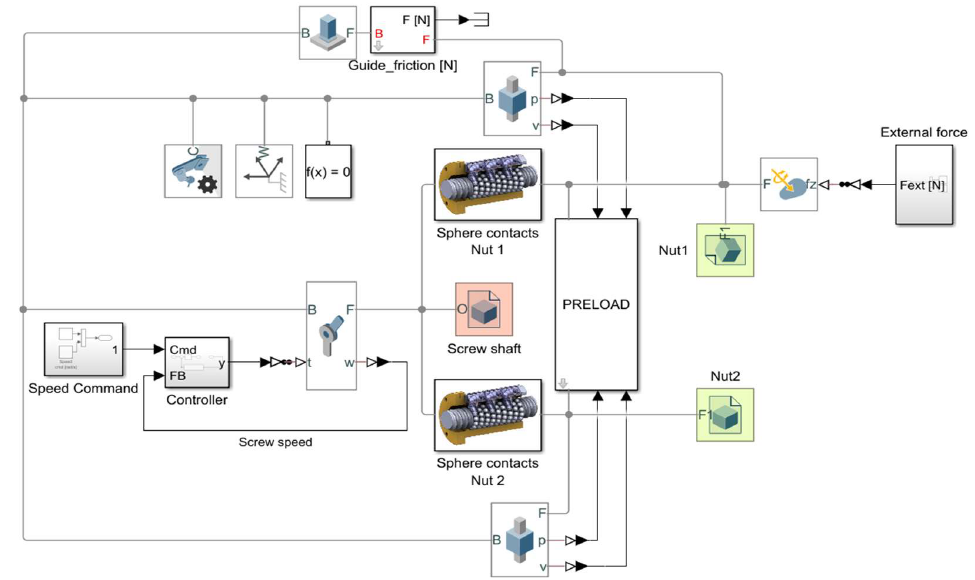
Figure 6. Main screen of the Simscape Multibody high-fidelity model of the ball screw component.